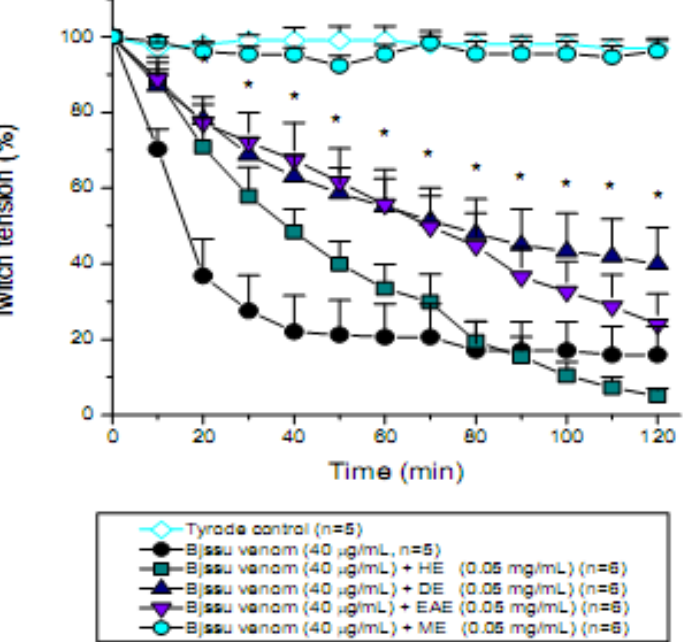
Figure 3. Pharmacological assays on mouse phrenic nerve-diaphragm preparations to determine the twitch response under electric indirect stimuli after incubation the preparation with 40 µg/mL B. jararacussu (Bjssu) venom pre-incubated for 30 min with the D. alata barks extract (0.05 mg/mL) using different solvents (HE, hexane; DE, dichloromethane; EAE, ethyl acetate; ME, methanol). Note that methanolic extract 100% prevented the neuromuscular blockade promoted by Bjssu venom alone whereas dichloromethane extract significantly decreased by ~15% the neuromuscular paralysis. See also that the hexane extract accentuated the toxic effect of venom. Each point represents the mean ± S.E.M. of the number of experiments (n) showed in the legend. *p < 0.05 compared to